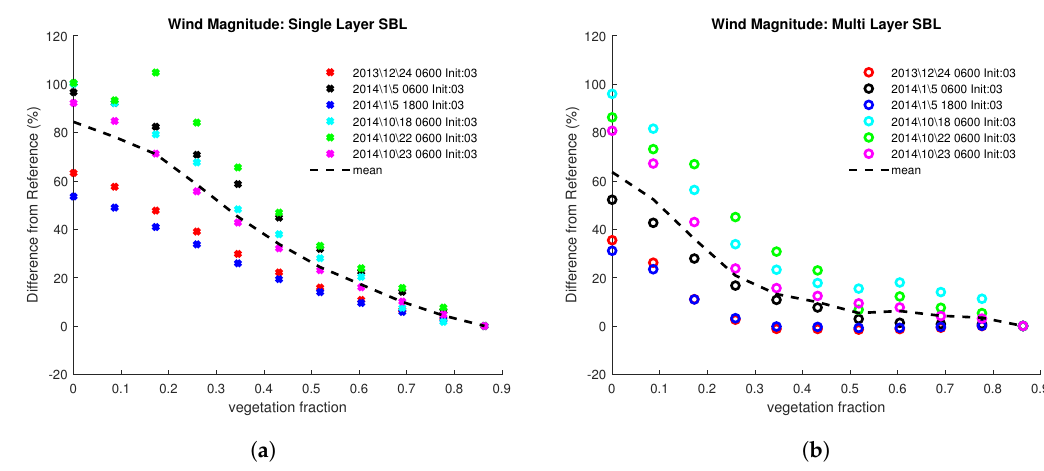
Figure 6. Percent difference of temporally averaged 117 m wind magnitude from the 86.3% vegetation case as a function of vegetation percentage for single layer SBL ( a ) and multilayer SBL scheme ( b ). The black dashed lined indicates the mean for each vegetation